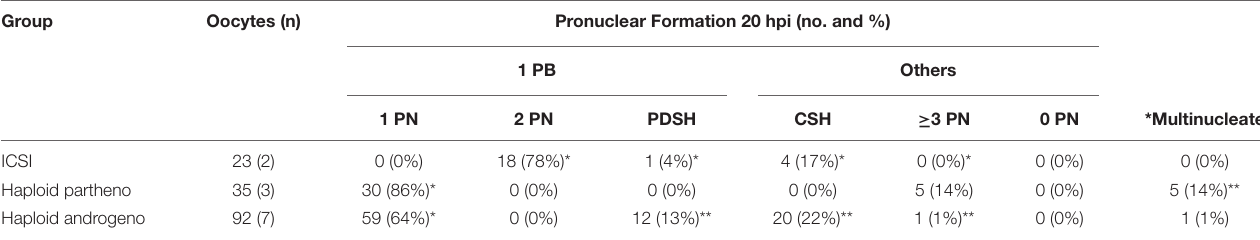
FIGURE 1 | Representative images of a 1-cell stage zygote fixed at 20 h after activation showing DNA staining (upper) and phase-contrast images (lower) of a ICSI biparental embryo (2 pronuclei), a haploid parthenogenetic embryo (1 female pronucleus; obtained by oocyte activation using ionomycin followed by cyclohexymide), and a haploid androgenetic embryo (1 male pronucleus; obtained by ICSI and oocyte enucleation). ICSI, intracytoplasmic sperm injection using female-sorted semen. Scale bar = 50 µ m. TABLE 3 | Formation of pronuclei and other chromatin structures in diploid (ICSI) and haploid zygotes (parthenogenetic and androgenetic) observed at 20 h after activation. Group Oocytes (n) Pronuclear Formation 20 hpi (no. and